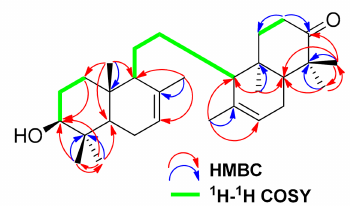
Figure 2. 1 H- 1 H COSY and HMBC correlations of compound 1